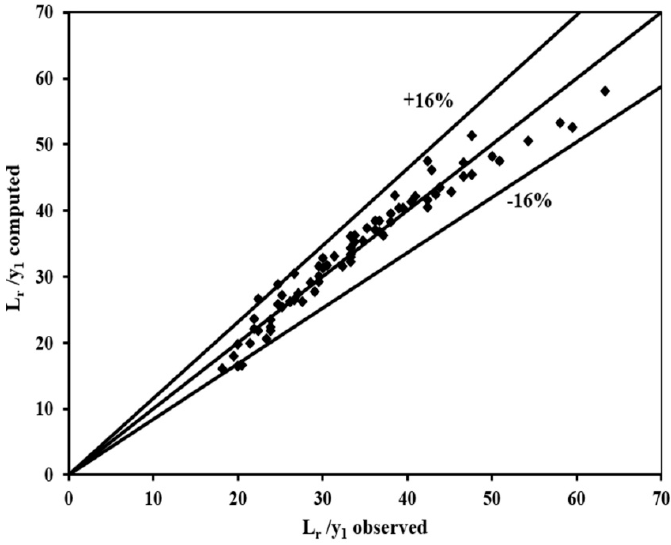
Figure 13. Relative roller length of the hydraulic jump as a function of upstream Froude number for two relative roughness heights ( ℎ 𝑦 (cid:2869) ⁄ = 0.67 and 1.33) and different expansion ratios ( 𝛼 = 0.33, 0.5, 0.67, 1) with asymmetry ratio of 𝛥 = 0.16.